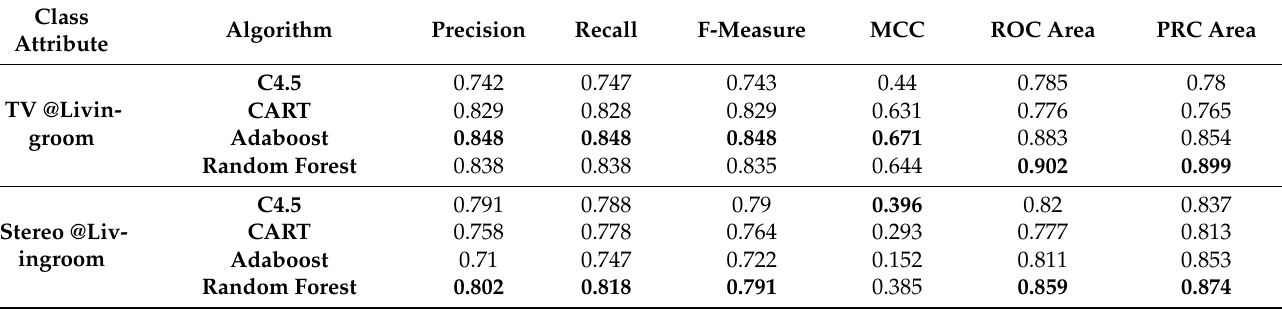
Table 6. Algorithms performance metrics